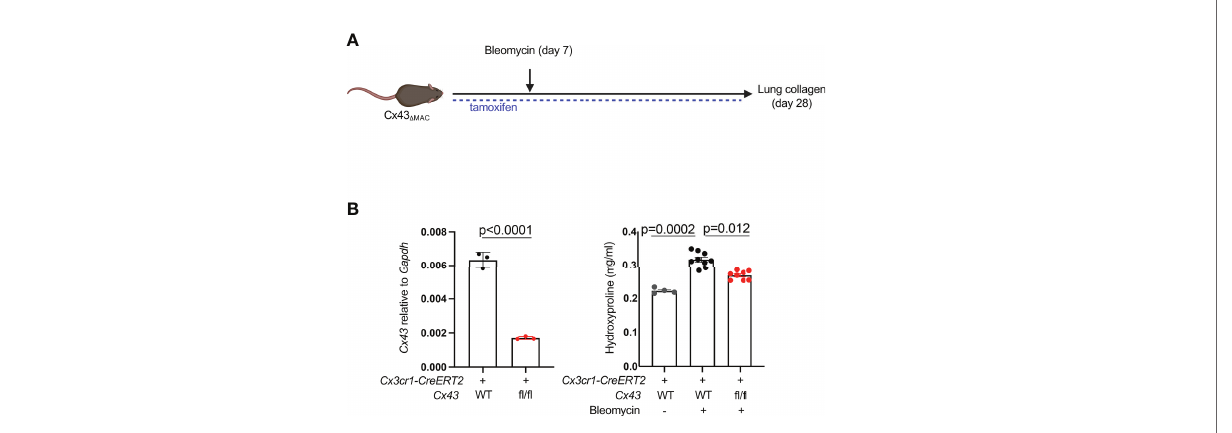
FIGURE 2 | MoMac Cx43 is required for lung fi brosis. (A) Schematic for testing the effect of macrophage-speci fi c Cx43 deletion on lung collagen after bleomycin injury with Cx3cr1-CreERT2: Cx43 fl / fl mice and controls. (B) qPCR of Cx43 expression in sorted tdTomato+ macrophages from Cx3cr1-CreERT2: R26-LSL- tdtomato: Cx43 fl / fl mice and Cx3cr1-CreERT2: R26-LSL-tdtomato controls. N=3 mice per condition. P value is for unpaired one-tailed t-test (left). Hydroxyproline assay of whole lung collagen from Cx3cr1-CreERT2: Cx43 fl / fl mice and Cx3cr1-CreERT2 controls. N=4, 9, and 8 mice as shown. P value is for one-way ANOVA followed by Kruskal-Wallis multiple comparison test (right).